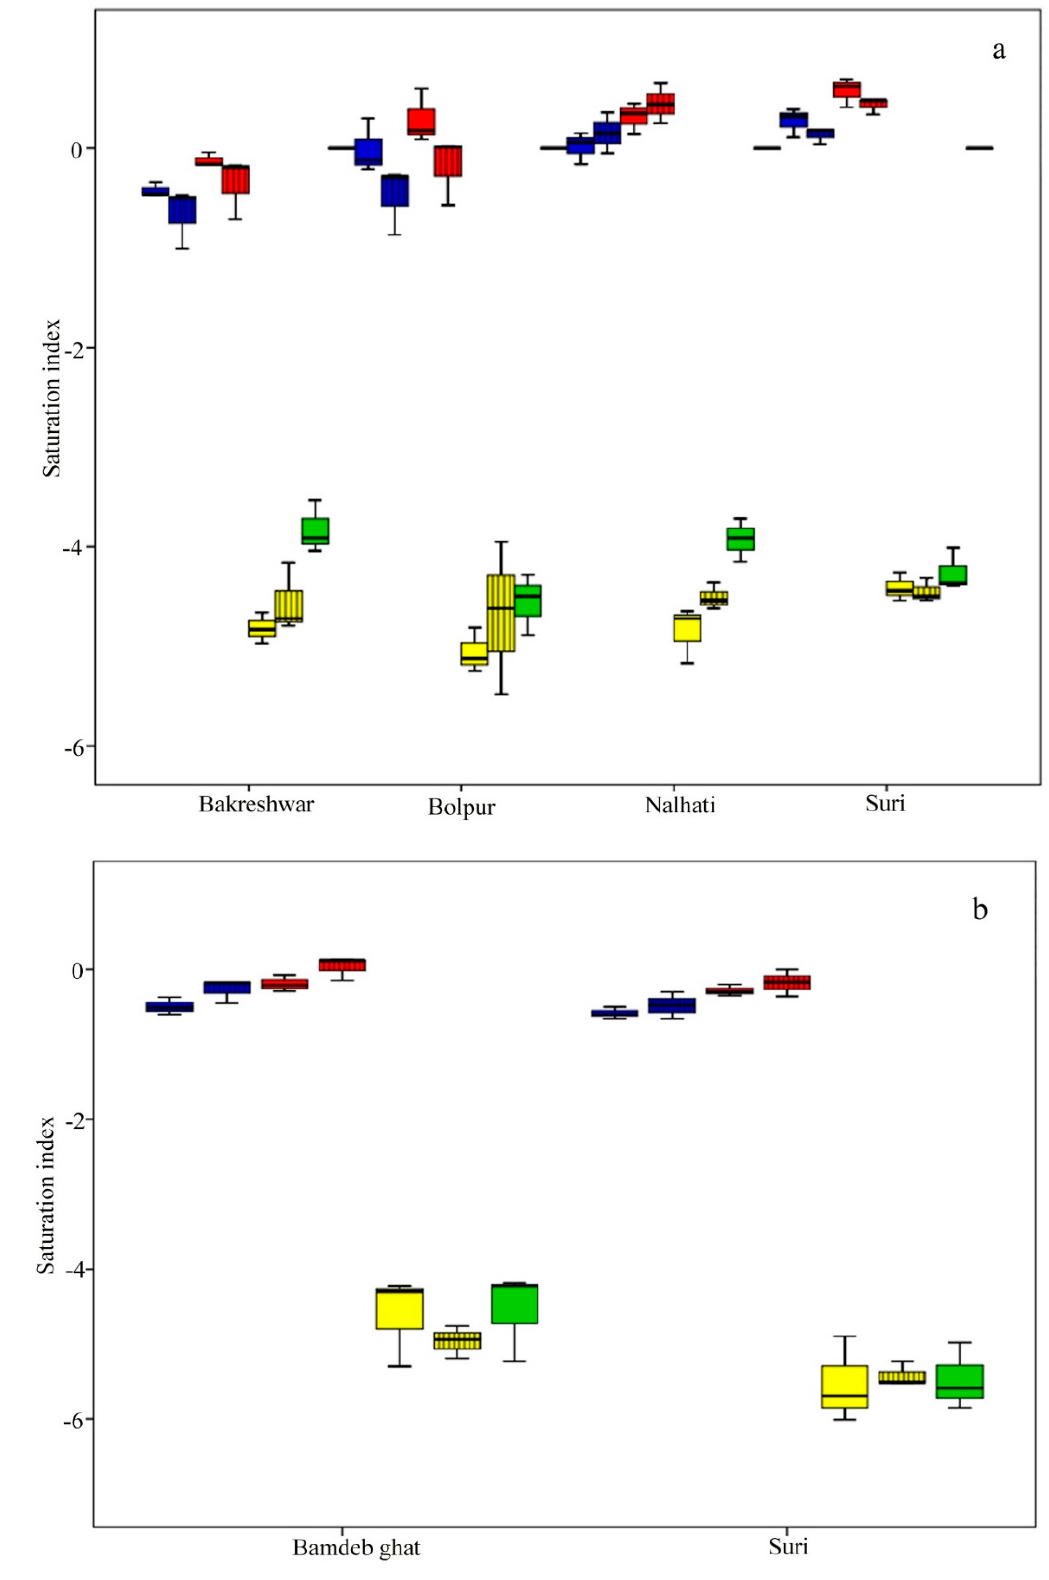
Figure 8. Spatio–temporal variation of saturation indices: ( a ) groundwater; ( b ) surface water (Notes: blue box indicates anhydrite, the red box indicates gypsum, the yellow box sylvite, and the green box halite, the solid box is in the pre-mon season, and the box with the black line is the post-mon season).